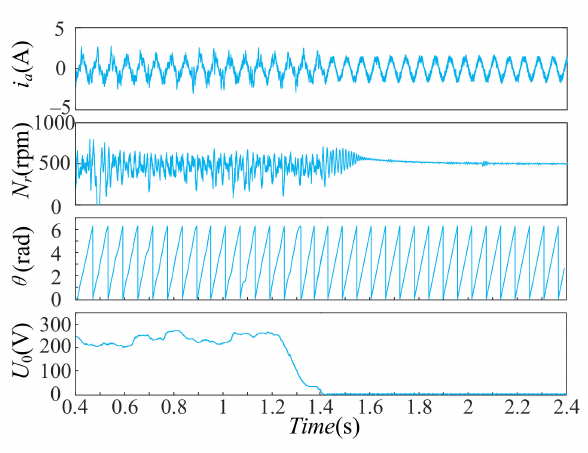
Figure 9. Experimental results of the NPV balance